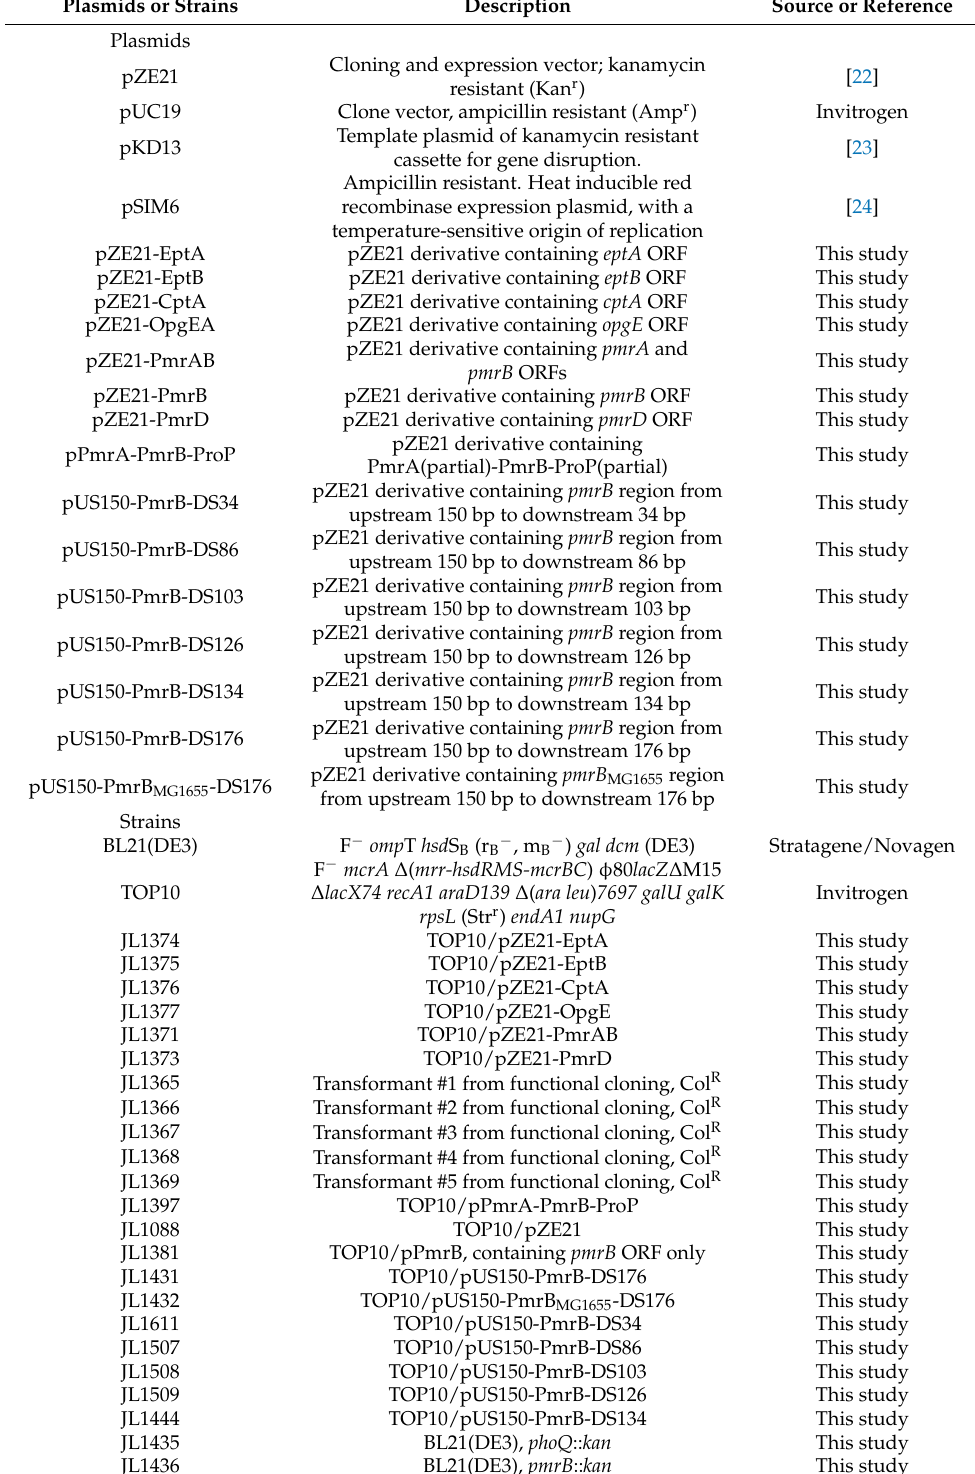
Table 1. Key bacterial plasmids and strains used in this